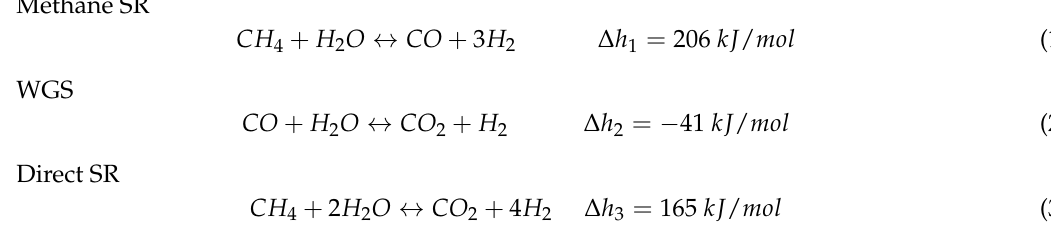
Figure 2. Fuel-reforming module flowsheet created by ASPEN HYSYS ® V7.2.